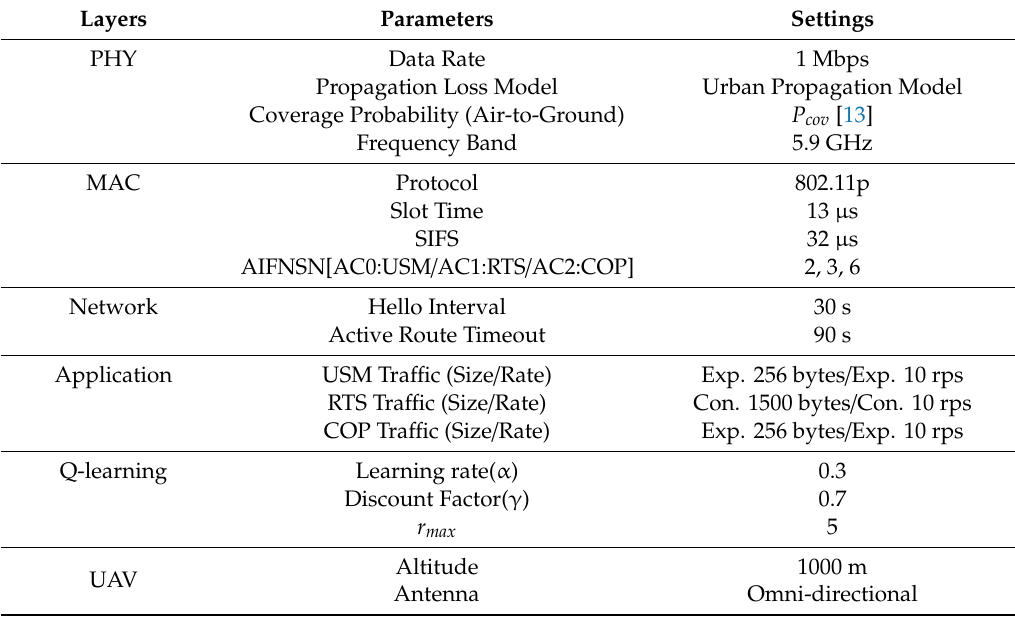
Table 2. Simulation